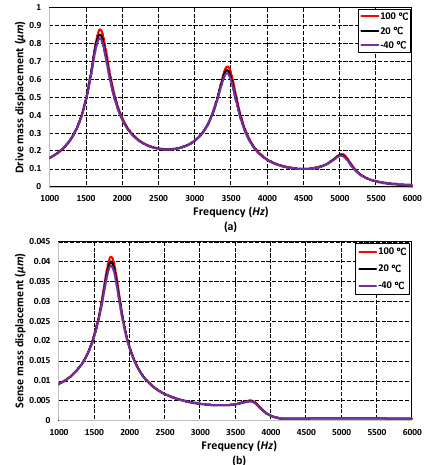
Figure 13. Effect of operating temperature variations on the frequency response of ( a ) drive mass m 3 and ( b ) sense mass m 3 b